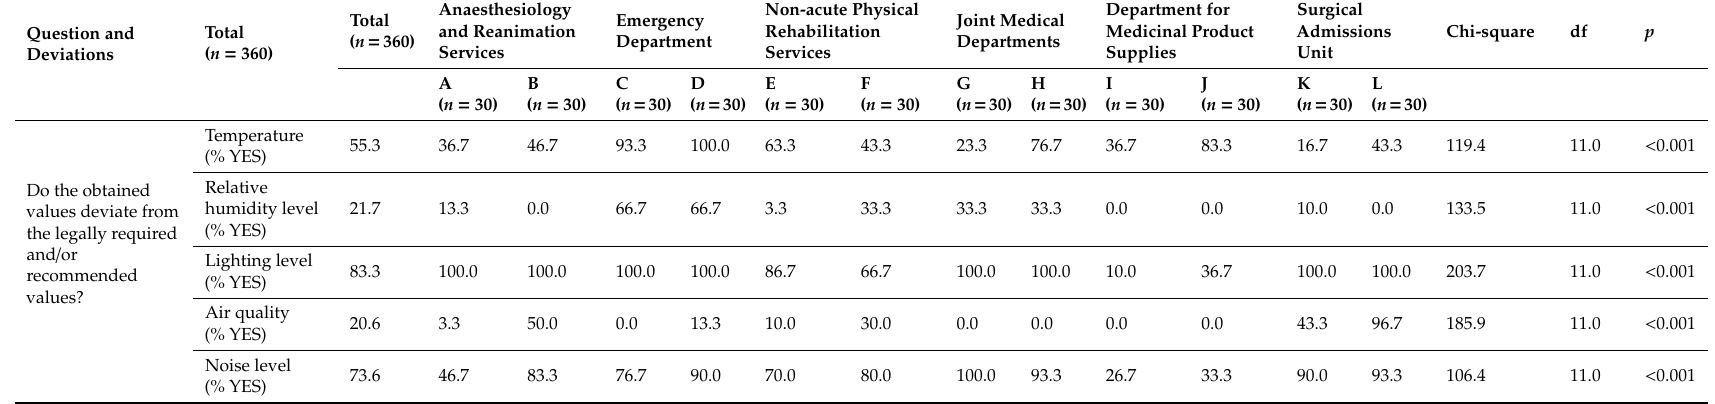
Table 4. Deviations (%) of obtained indoor environmental quality parameter values from the legally required and / or recommended values in the selected hospital